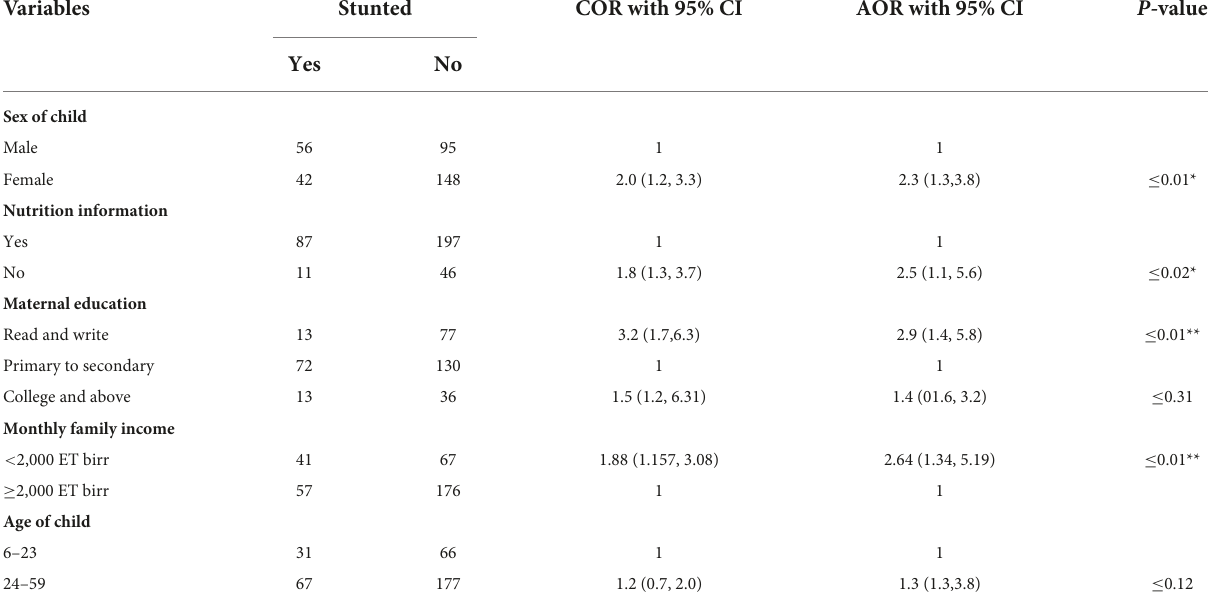
TABLE 3 Bivariate and multivariate analysis for stunting among unemployed mothers in Gurage Zone, SNNPR, Ethiopia, 2021 ( n = 671). Variables Stunted COR with 95%